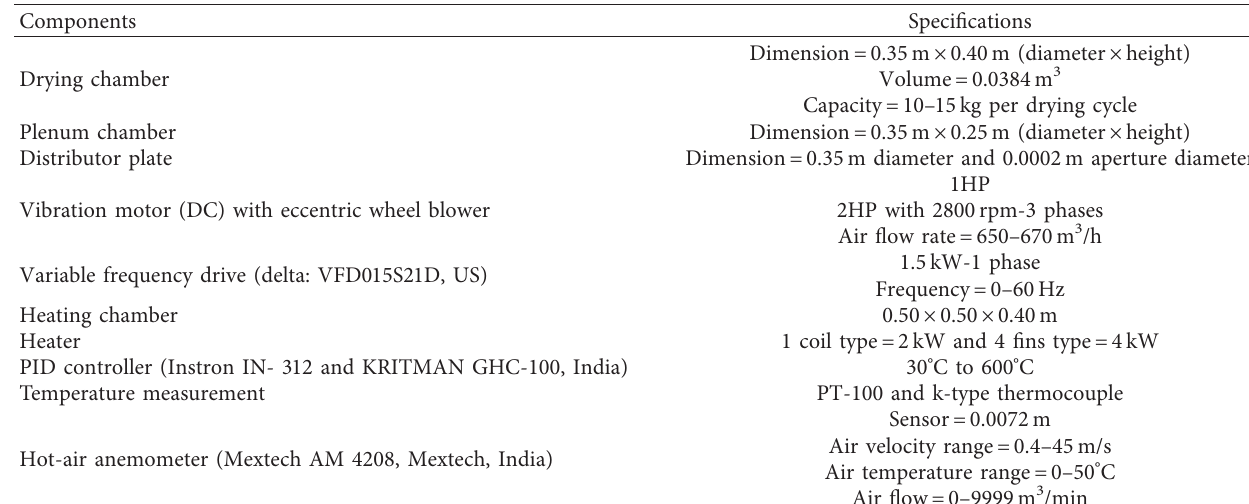
Figure 1: Schematic diagram of the vibro-fluidized bed dryer. Table 1: Design specifications of the vibro-fluidized bed dryer.